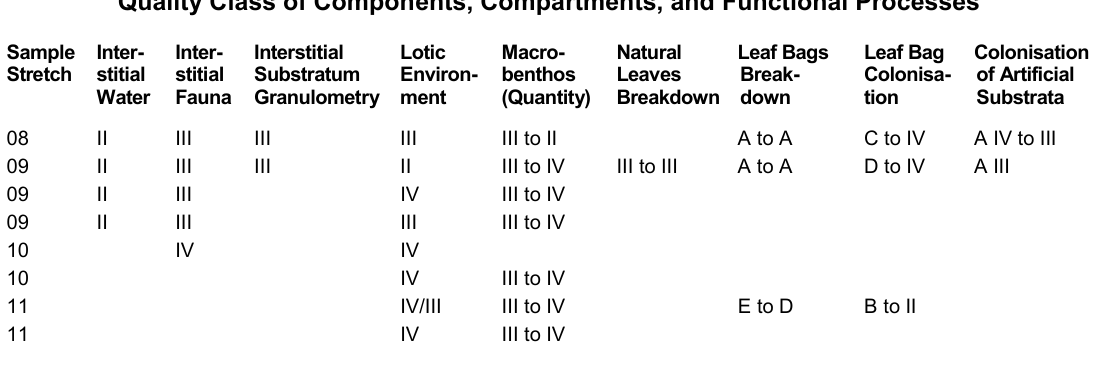
Quality Class of Components, Compartments, and Functional